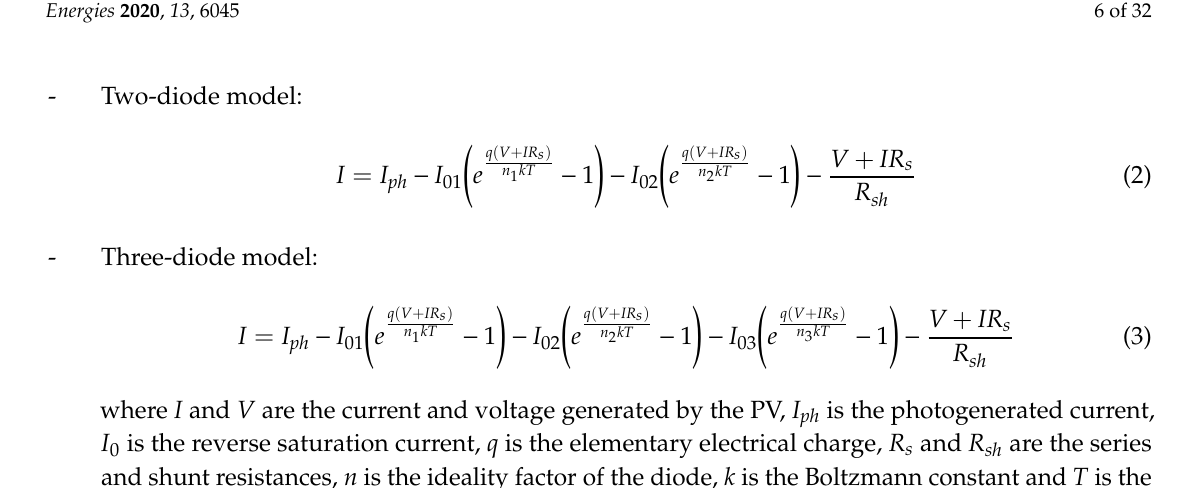
Figure 6. PV models: ( a ) one-diode model; ( b ) two-diode model; ( c ) three-diode model.